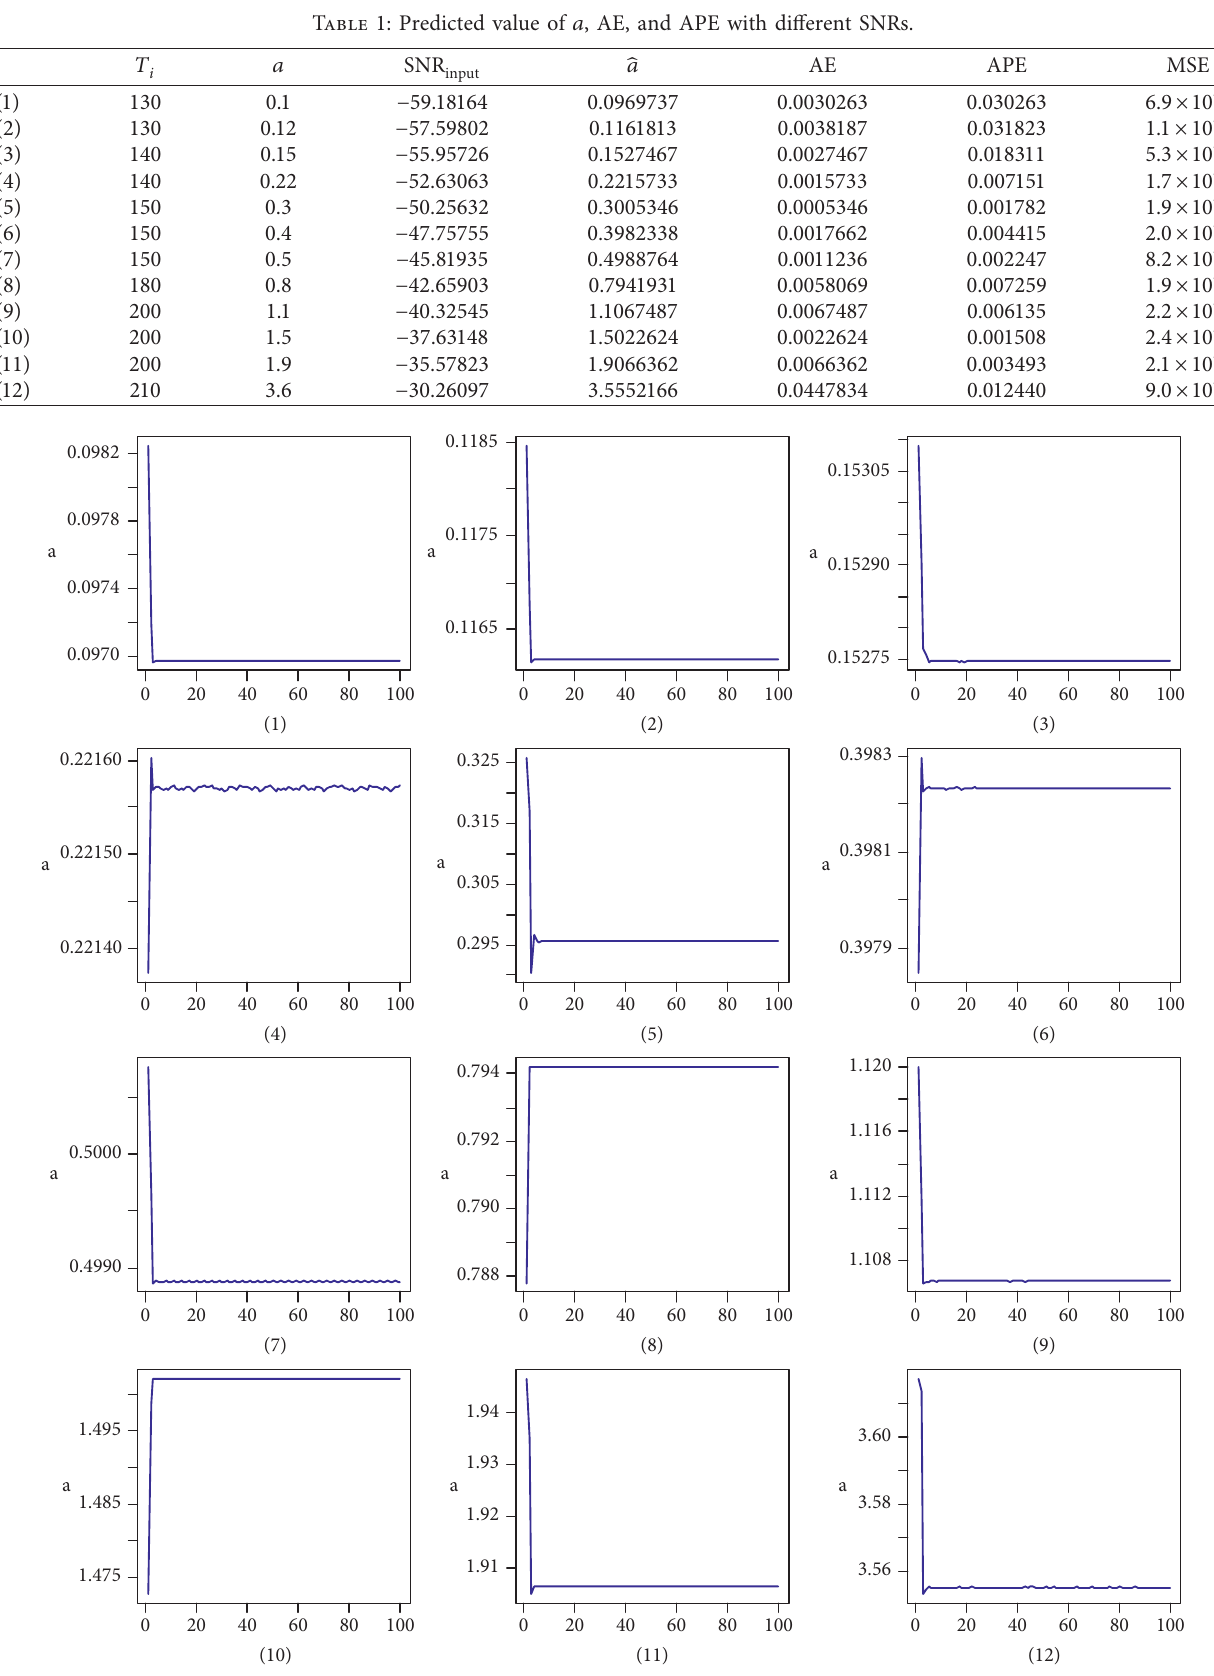
Figure 3: Iteration results of the proposed algorithm for Example 1. (1) The iteration result at a � 0.1. (2) The iteration result at a � 0.12. (3) The iteration result at a � 0.15. (4) The iteration result at a � 0.22. (5) The iteration result at a � 0.3. (6) The iteration result at a � 0.4. (7) The iteration result at a � 0.5. (8) The iteration result at a � 0.8. (9) The iteration result at a � 1.1. (10) The iteration result at a � 1.5. (11) The iteration result at a � 1.9. (12) The iteration result at a �